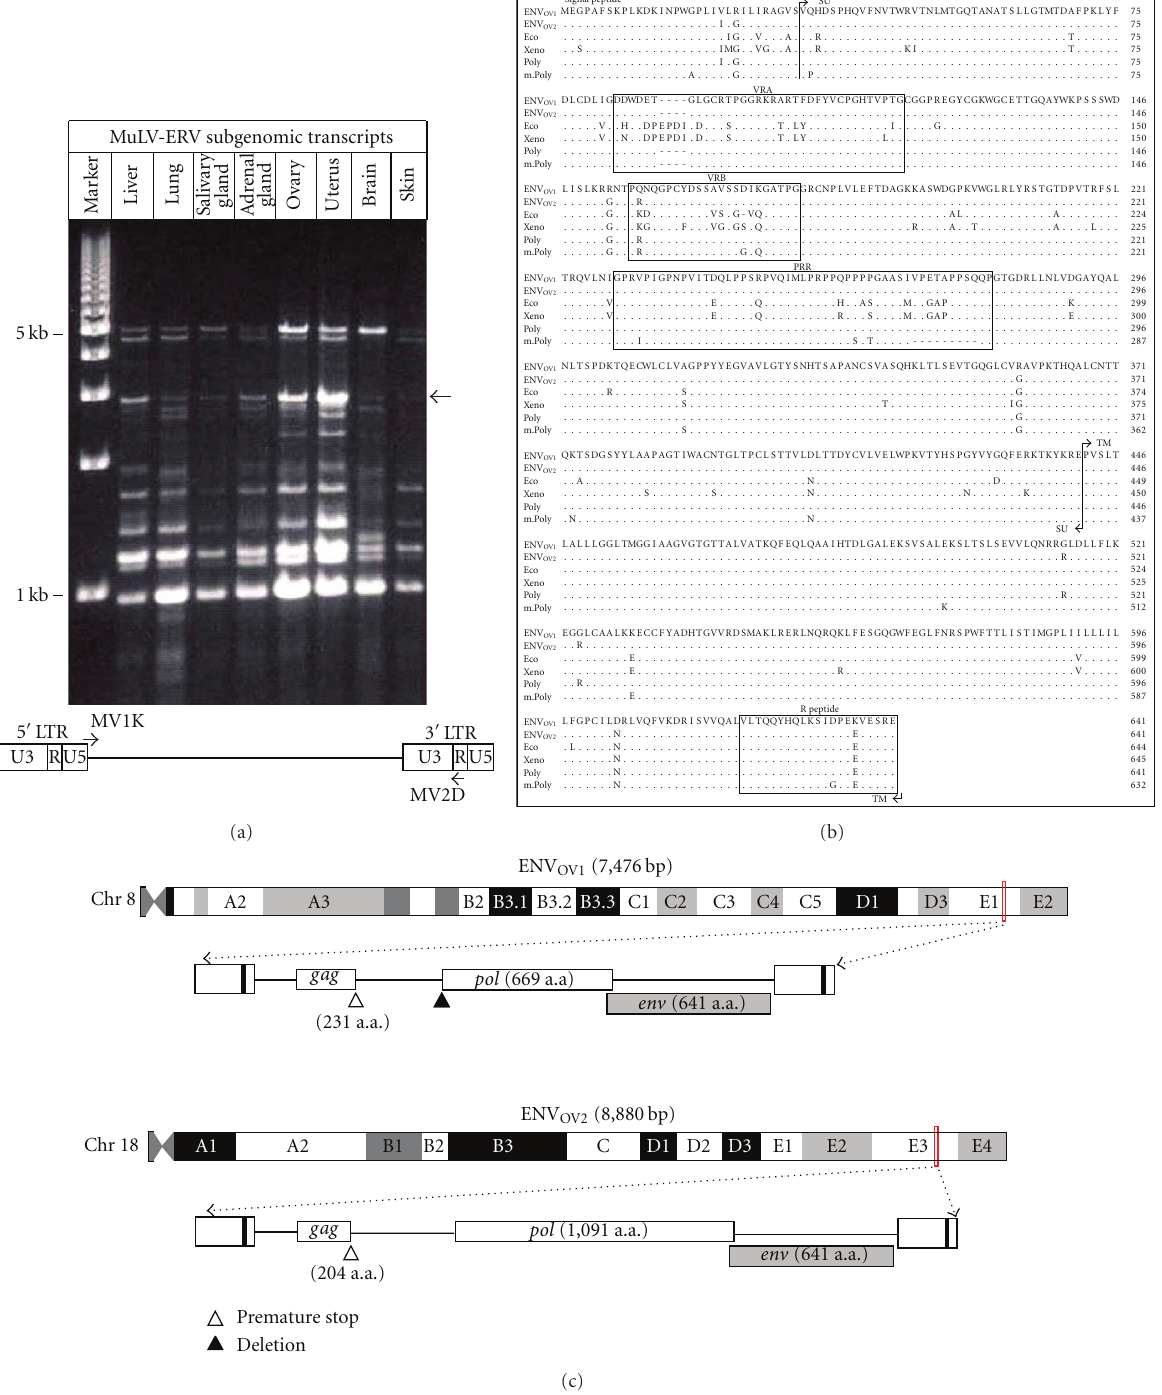
Figure 1: Identification of full-length env transcripts from the ovary of C57BL/6J mice. (a) A number of MuLV-ERV subgenomic transcripts were expressed in normal tissues (liver, lung, salivary gland, adrenal gland, brain, and skin) of C57BL/6J mice. A schematic diagram indicates the locations of primers used for amplification of the subgenomic transcripts. (b) The amino acid sequences of two intact env genes, named ENV OV1 and ENV OV2 , which were isolated from the ovary (indicated with an arrow in panel (a)), were compared to reference env polypeptides with known tropism traits (GeneBank accession number: AAG39911 (Eco), ACY30460 (Xeno), AAO37283 (Poly), and AAA88318 (m.Poly)). (c) The putative MuLV-ERV proviruses harboring the ENV OV1 and ENV OV2 genes were mapped to chromosomes 8 and 18 of C57BL/6J genome, respectively. SU (surface domain), TM (transmembrane domain), VRA (variable region A), VRB (variable region B), PRR (proline rich region), LTR (long terminal repeat), R (repeat), and U (unique